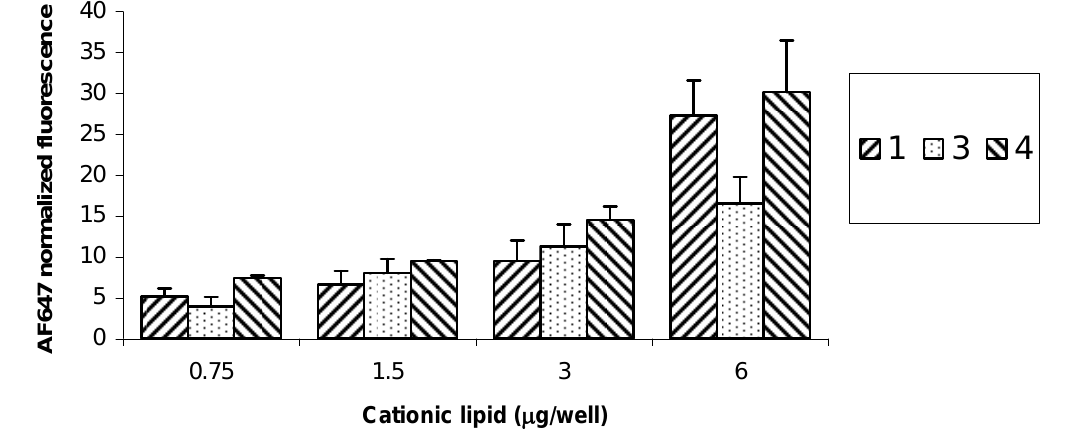
Figure 4. Delivery of siRNA (15 nM, 15 pmol/well) against GFP (labelled with Alexa Fluor® 647 at the 3'-position of the sense strand) using 1 , 3 , and 4 . Values are presented as means of normalized geometric mean fluorescence of AF647 ± SD (n = 6).